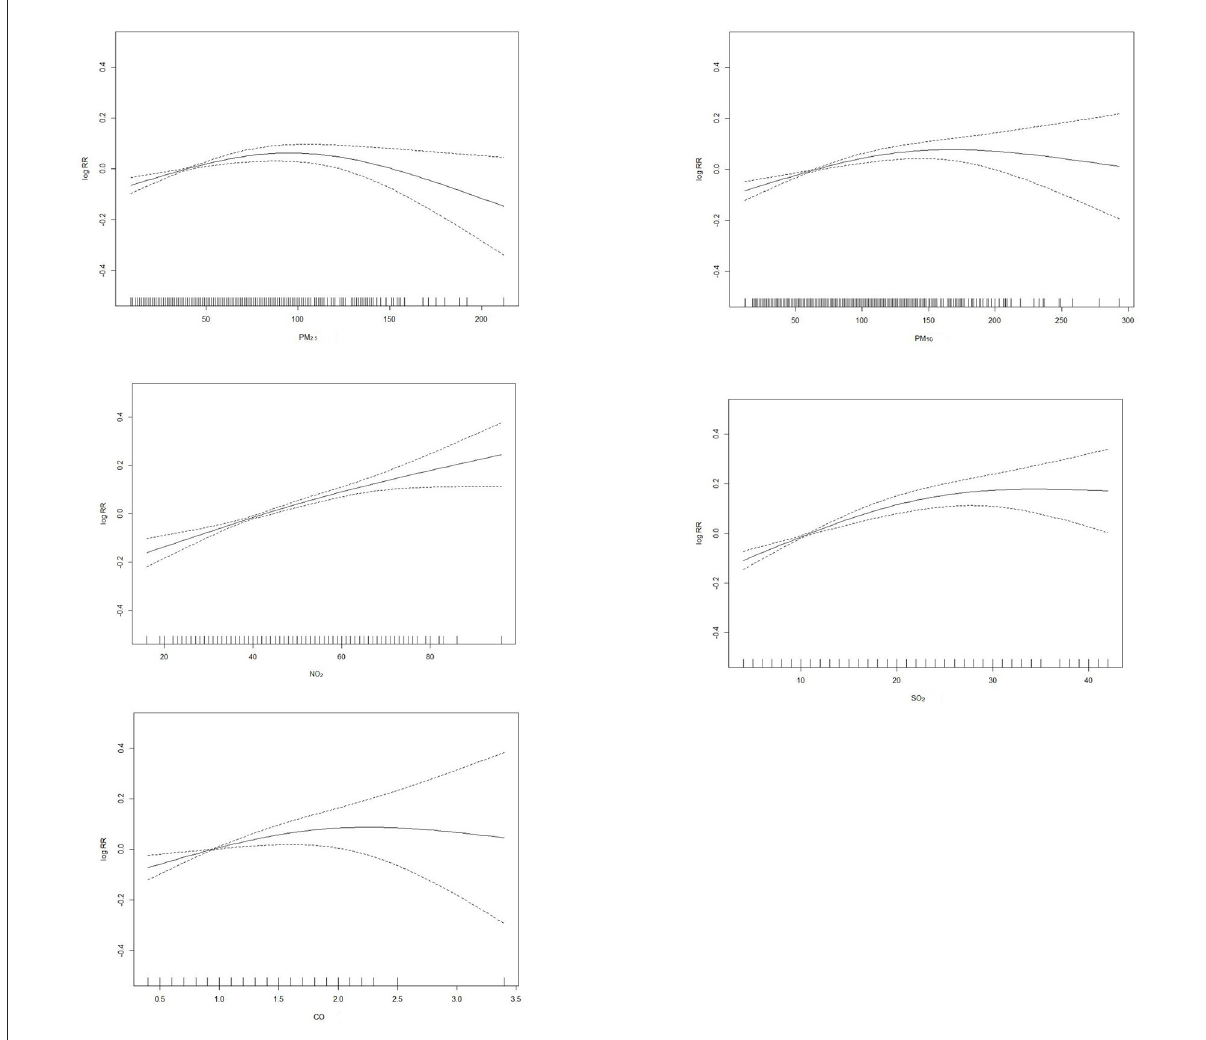
FIGURE2 Dose-response curves for different air pollutants in Chongqing, China.